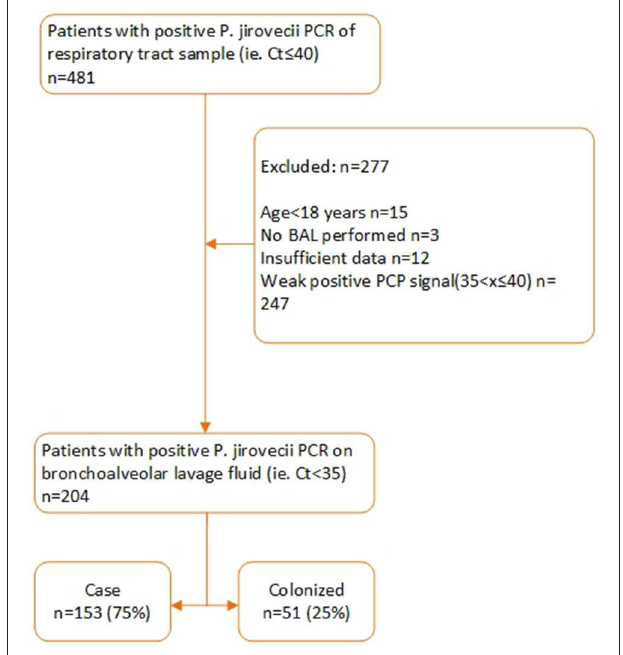
FIGURE 1 | Overview of the inclusion